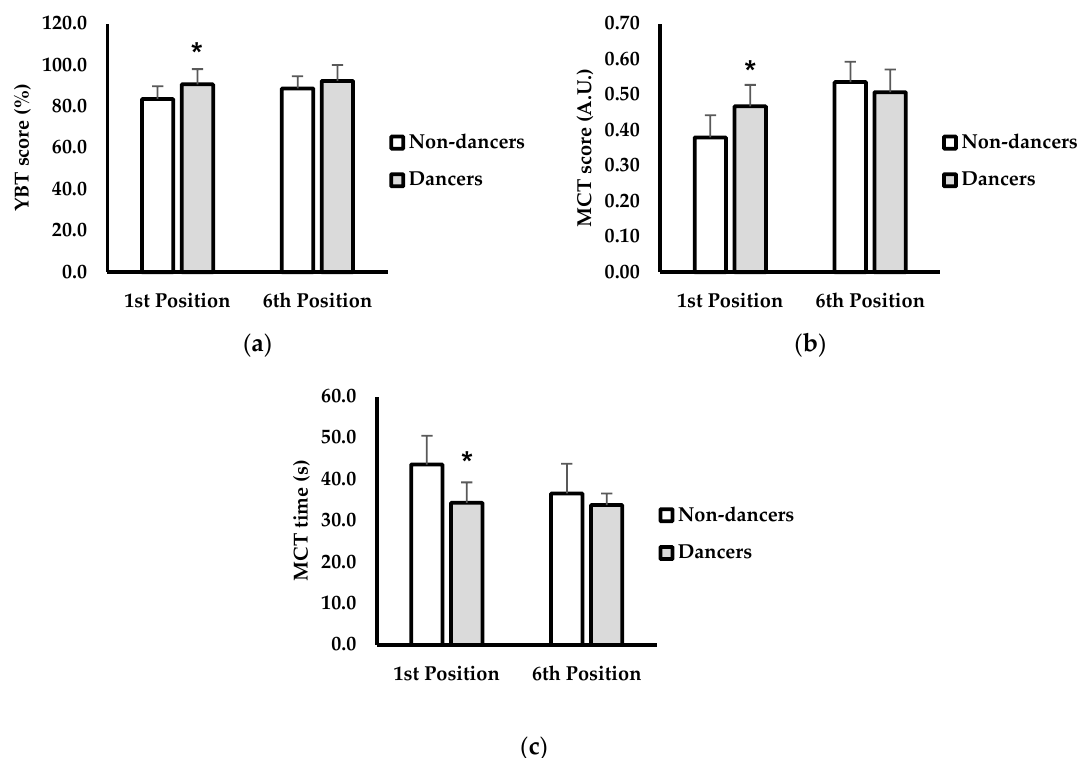
Figure 2. ( a ) Composite Y-balance test (YBT) scores (%) in 1st ballet position and 6th ballet position between non-dancers (white) and dancers (grey); ( b ) Biosway motor control test (MCT) scores (arbitrary units, A.U.) in 1st ballet position and 6th ballet position between non-dancers (white) and dancers (grey); ( c ) MCT completion time (s) in 1st ballet position and 6th ballet position between non-dancers (white) and dancers (grey); data are presented as mean ± SD. * Indicates significantly di ff erent from 1st position non-dancer ( p <